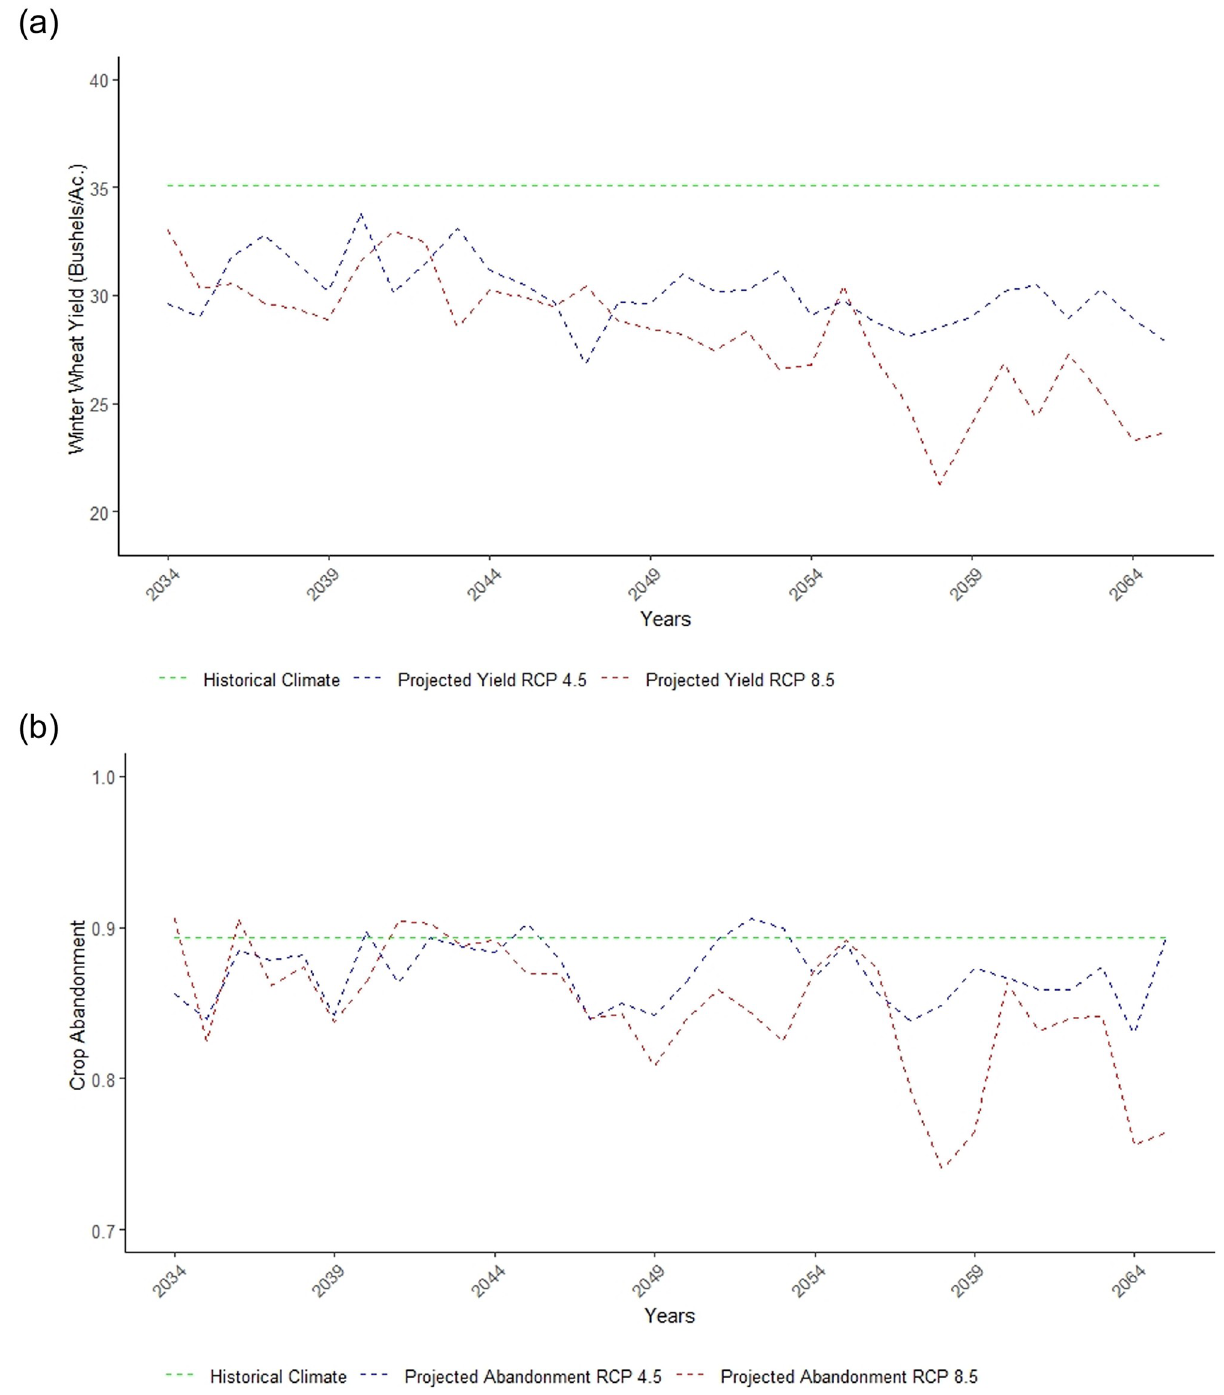
Fig 3. Climate change losses over time. (A) Projected yield of winter wheat by year under scenarios RCP 4.5 and RCP 8.5. The dashed green line is the average yield with a historical climate. (B) The projected proportion of acres harvested of winter wheat by year under scenarios RCP 4.5 and RCP 8.5. The dashed green line is the average proportion harvested with the historical climate.